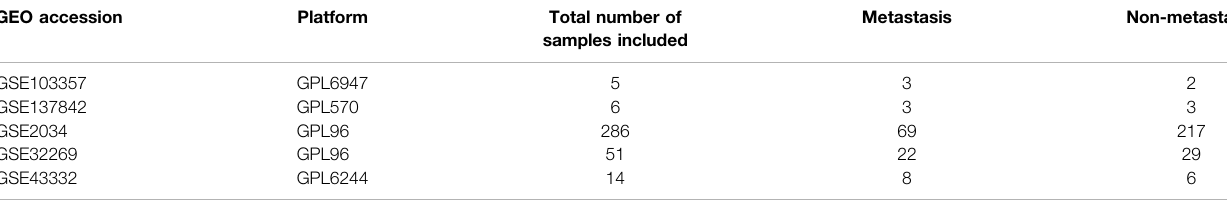
TABLE 1 | Information of the gene expression datasets from GEO.